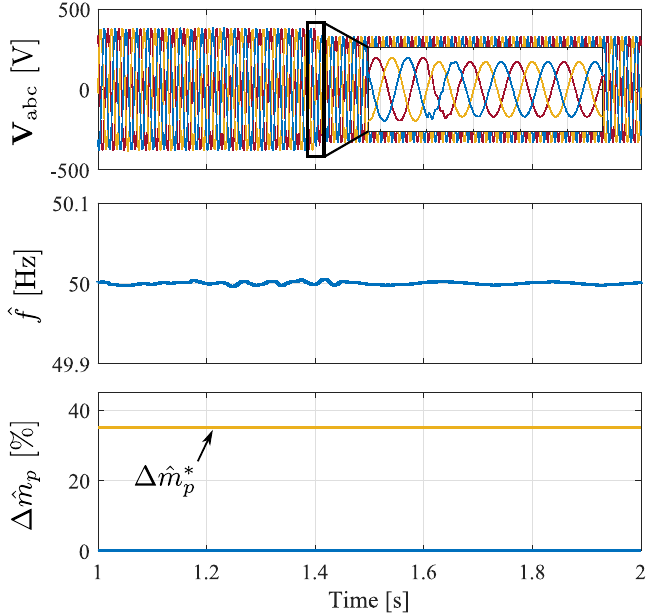
Figure 9. Case 4: Voltage dip test to discard false